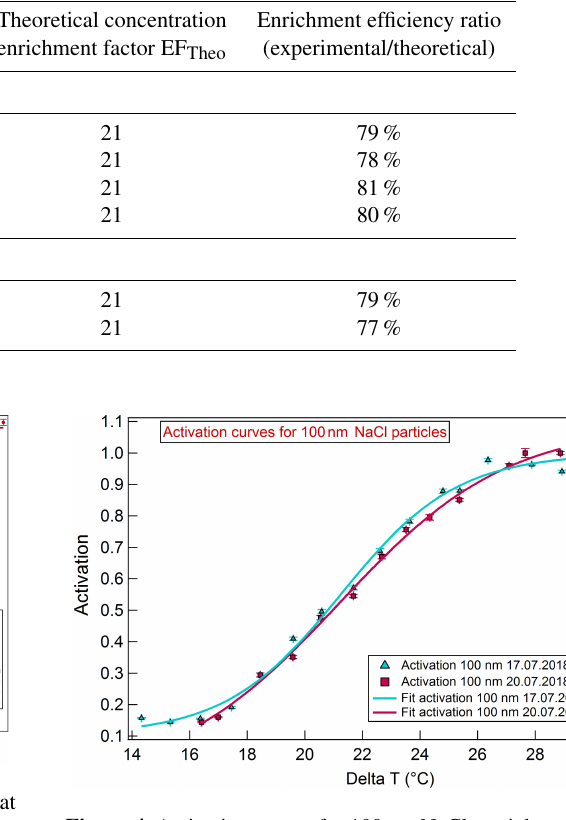
Figure 4. Activation curves for 100nm NaCl particles measured on two different days. Both curves are